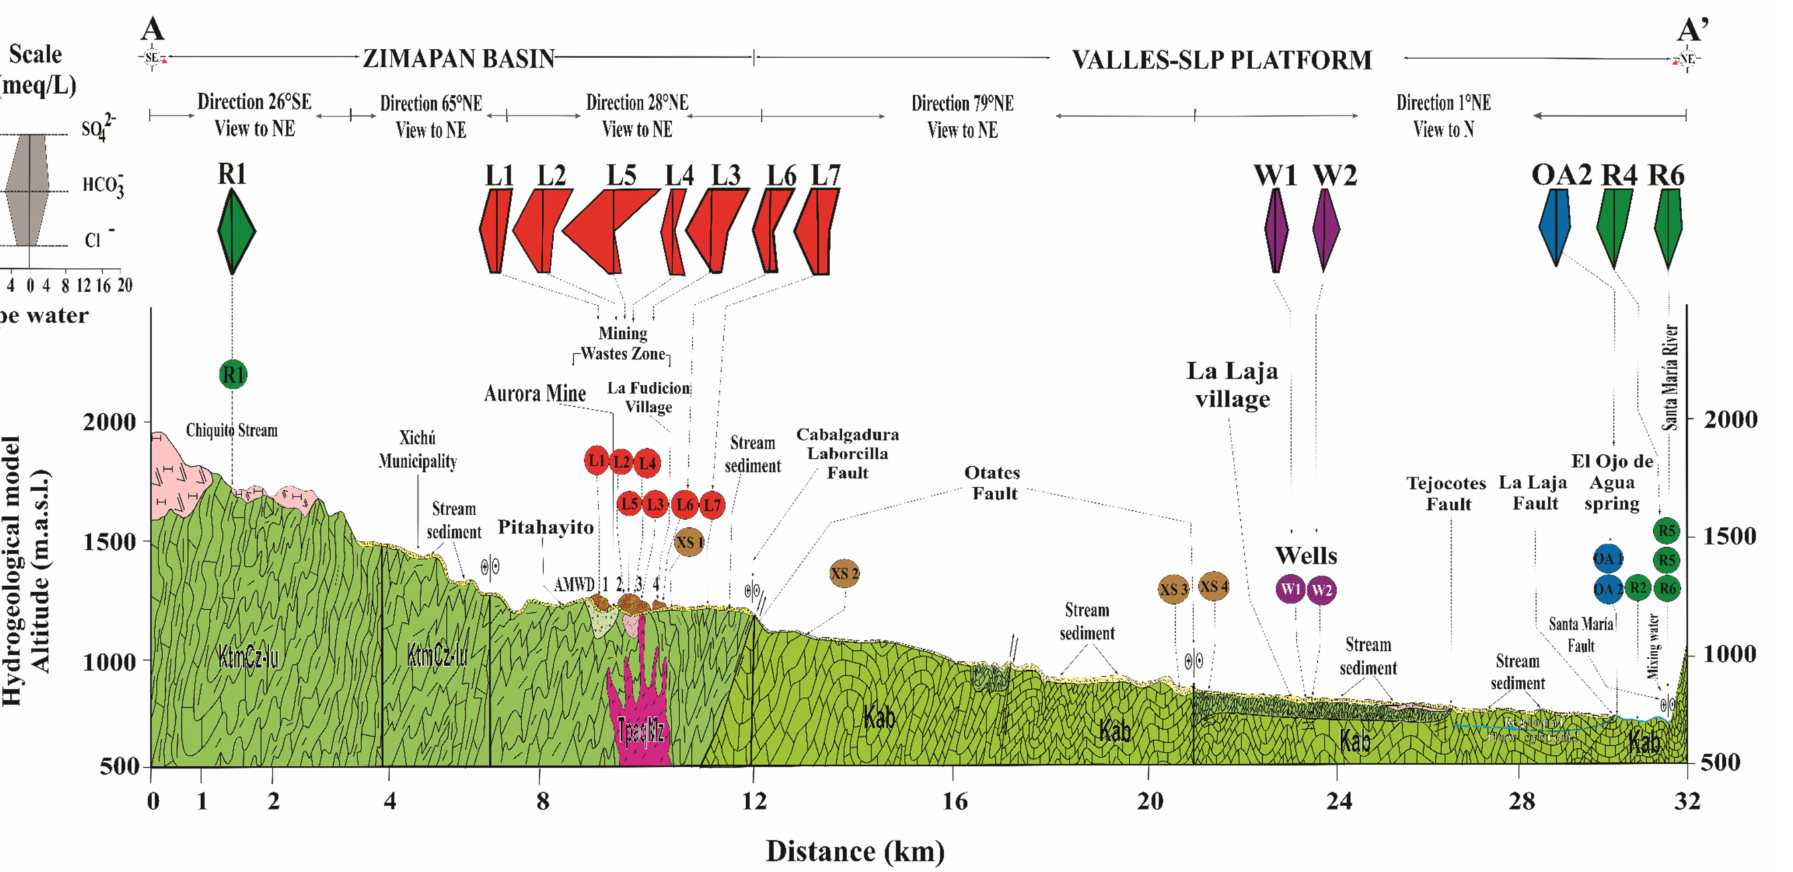
Figure 5. Conceptual model of water and flux of fine PTE-bearing particles in the study area. Leachate samples in red circles are under acid-neutral and oxidant